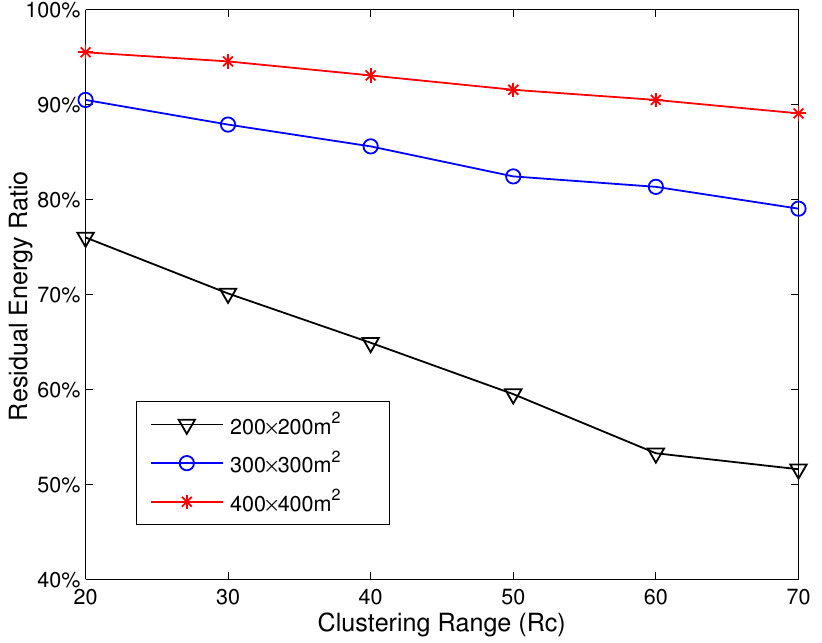
Figure 1. The residual energy ratio with different R